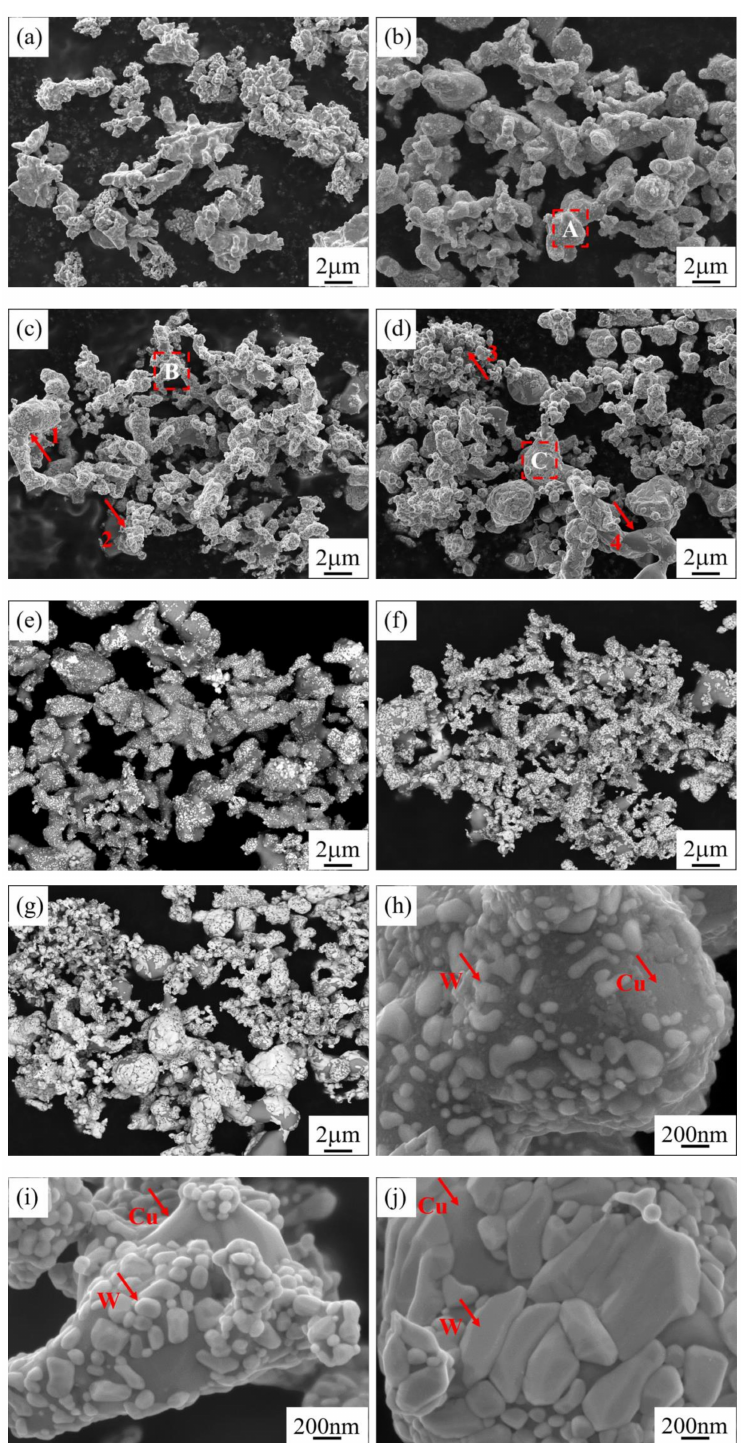
Figure 14. SEM and BSE images of Cu, Cu-10 wt%W, Cu-20 wt%W, and Cu-30 wt%W reduced powders: ( a ) SEM images of Cu; ( b ) SEM and ( e ) BSE images of Cu-10 wt%W; ( c ) SEM and ( f ) BSE images of Cu-20 wt%W; ( d ) SEM and ( g ) BSE images of Cu-30 wt%W; ( h ) enlarged view of area A of Figure 14b; ( i ) enlarged view of area B of Figure 14c; ( j ) enlarged view of area C of Figure